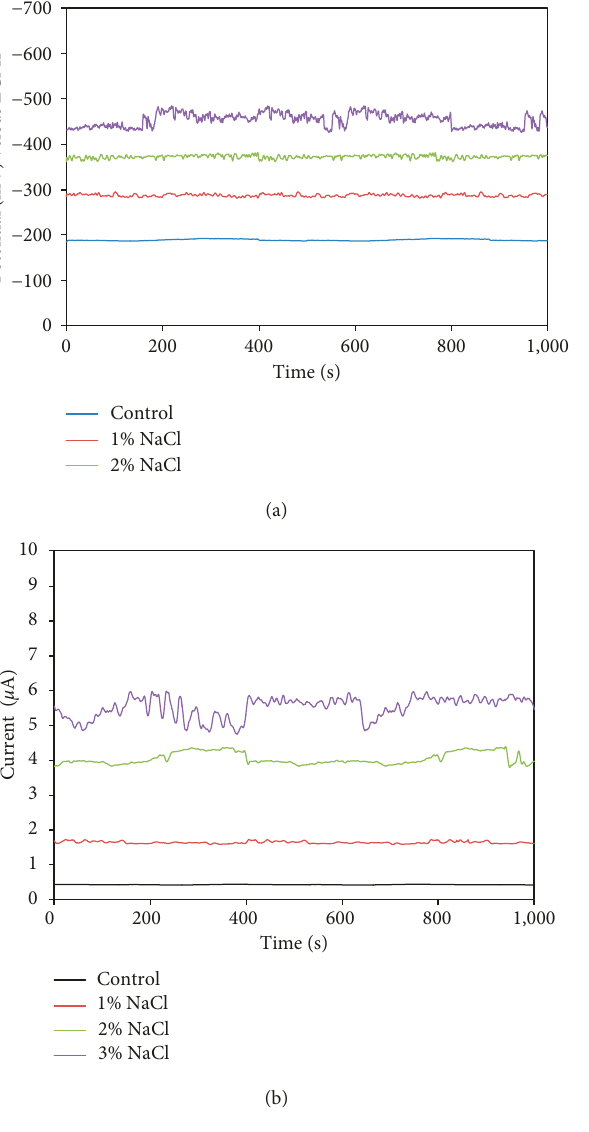
Figure 5: Time records of the potential (a) and current (b) signals for the rebar embedded in chloride-contaminated concrete.